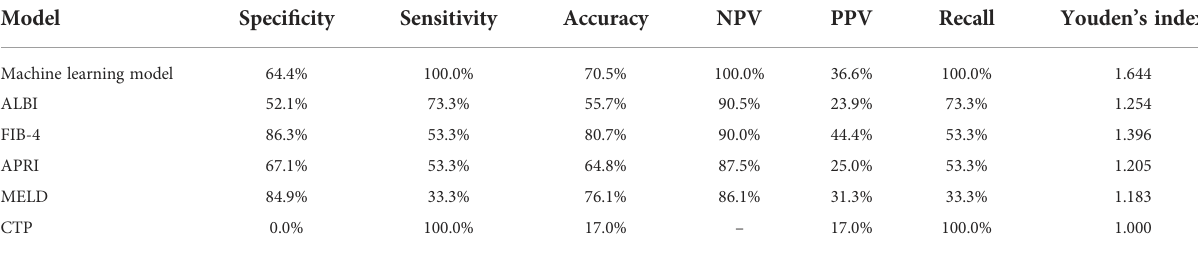
TABLE 3 Predictive power of the ML model and routine clinical models using data of the validation cohort.